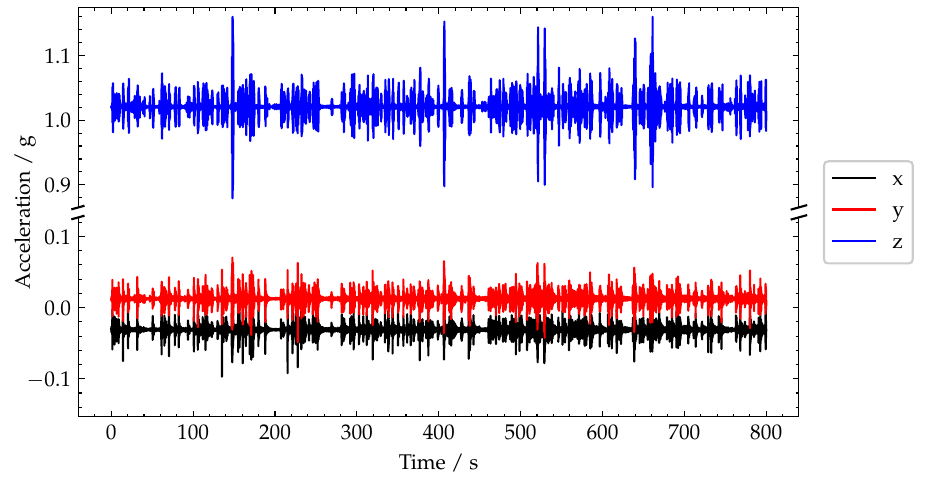
Figure 13. Plot of recorded acceleration